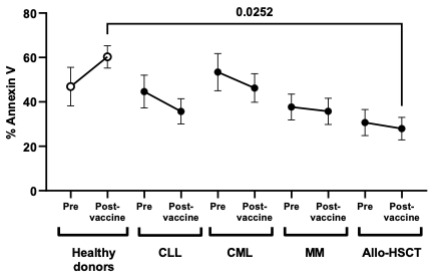
Figure 3. ADCC response against SARS-CoV-2 vaccine of PBMCs from individuals with OHD. Quantification by flow cytometry of the expression of phosphatidylserine by Annexin V in rituximab-coated Raji cells co-cultured with peripheral blood mononuclear cells (PBMCs) from individuals with chronic lymphocytic leukemia (CLL), chronic myeloid leukemia (CML), multiple myeloma (MM), or allogeneic stem cell transplant (Allo-HSCT), before and after receiving one dose of SARS-CoV-2 vaccine, in comparison with healthy donors. Each dot in the graphs corresponds to mean ± SEM. Statistical significance between groups was calculated using one-way ANOVA test.